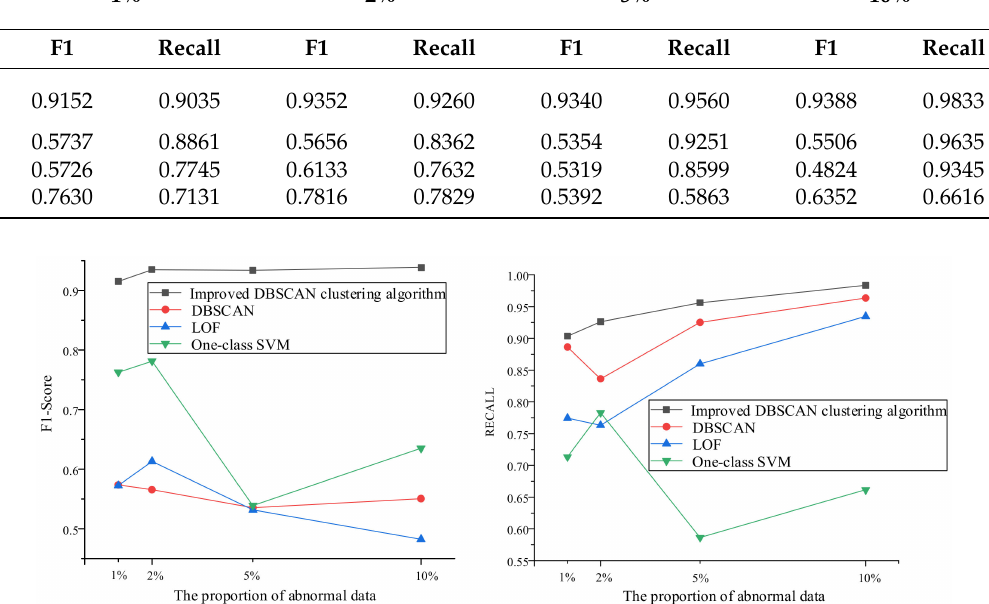
Figure 9. F1-score and recall of improved DBSCAN clustering algorithm, DBSCAN algorithm, LOF algorithm, and one-class SVM algorithm under different proportions of abnormal